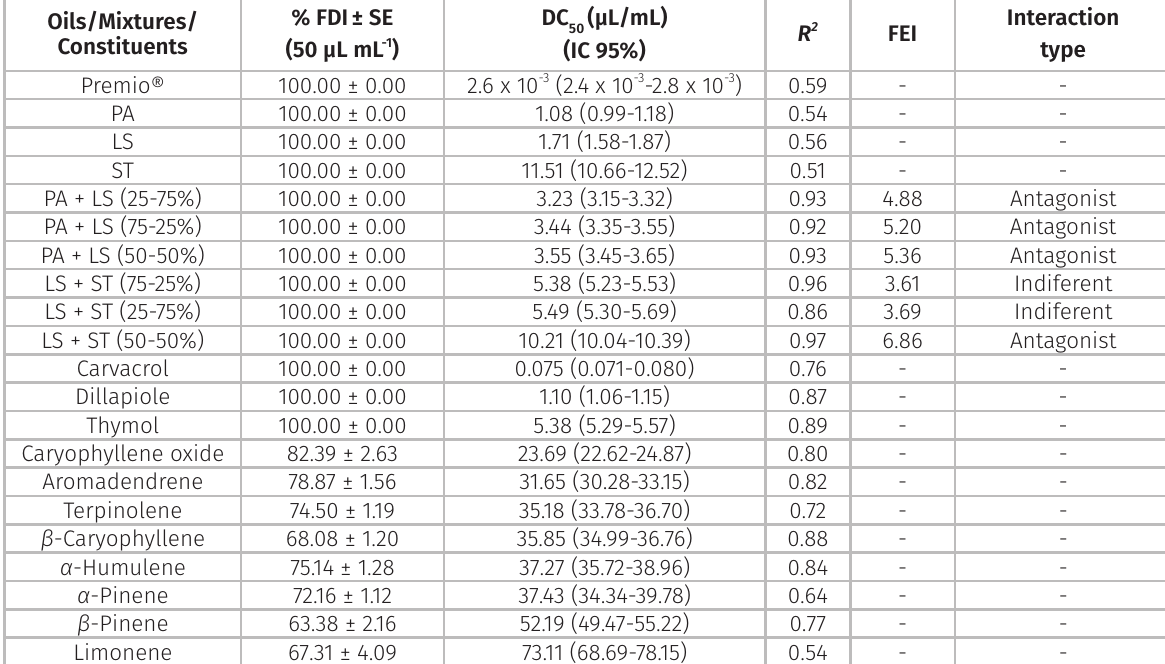
Table III. Activity feeding deterrent of essential oils from the leaves of Piper aduncum (PA) Schinus terebinthifolius (ST) and Lippia sidoides (LS), their binary mixtures, Premio ® as a positive control and selected oils constituents against lavae of 3 rd instar on Plutella xylostella (L.) (Lepidoptera: Plutellidae) in laboratory. Temp.: 25 ± 1°C, RH: 65 ± 5% and photophase: